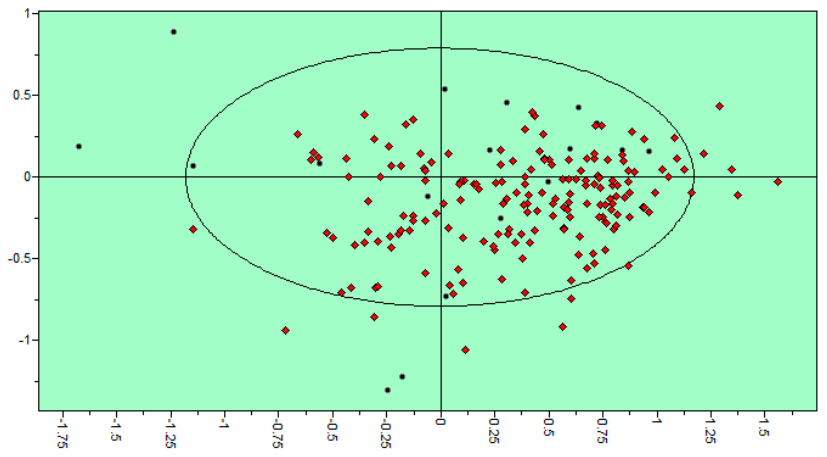
Figure 5. PLS scores of 200 candidates in the Leishmania arginase 3D QSAR model. Red: candidates, black: 18 Leishmania arginase inhibitors.